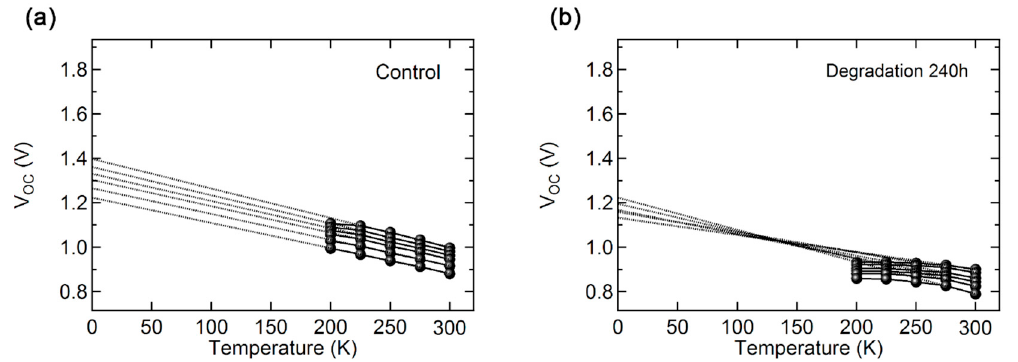
Figure 4. Temperature dependent V OC plot with different light intensity for ( a ) control device and ( b ) 240 h degraded device. Light intensity varies from 2 to 100 mW/cm 2 . V OC increases by increasing light intensity. The dashed line represents extrapolation of the temperature dependent V OC data. The data points for the extrapolation range from 250 K to 300 K.